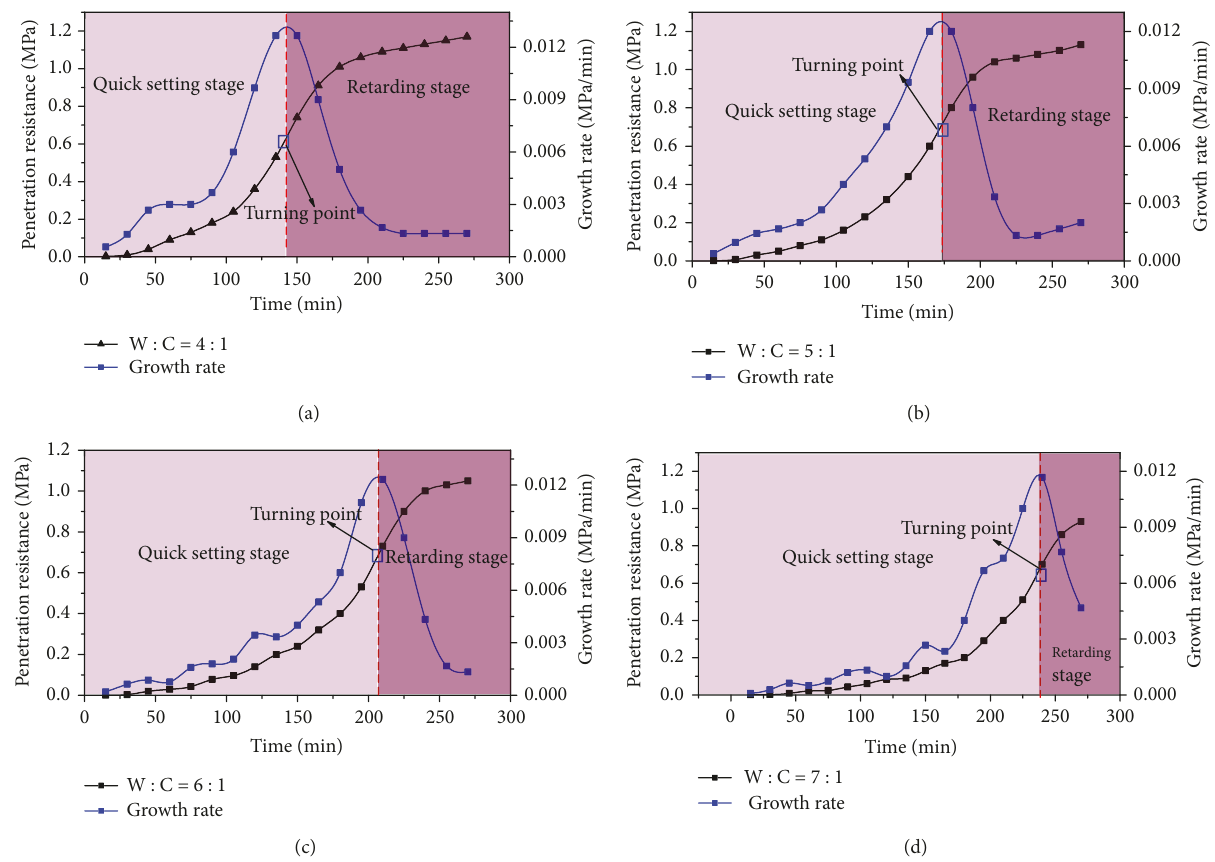
Figure 7: Relationship between the fi nal setting time and penetration resistance of expandable slurry with high water content.